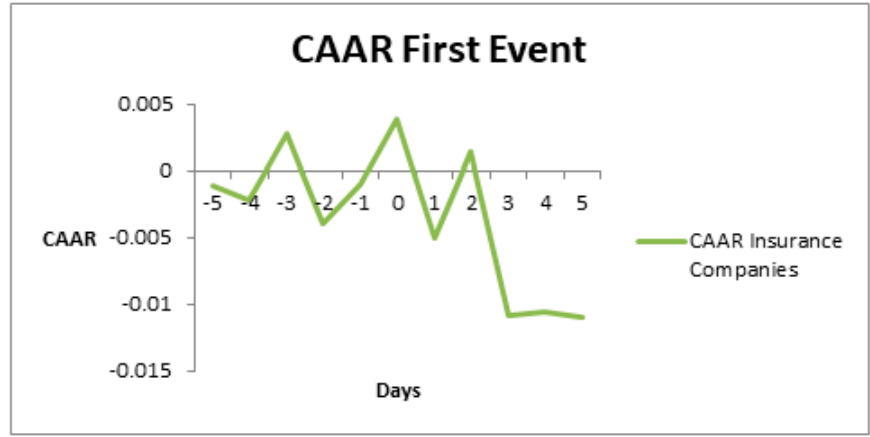
Figure A4. C AARs for insurance companies associated with the first event. Source: Authors’ work.